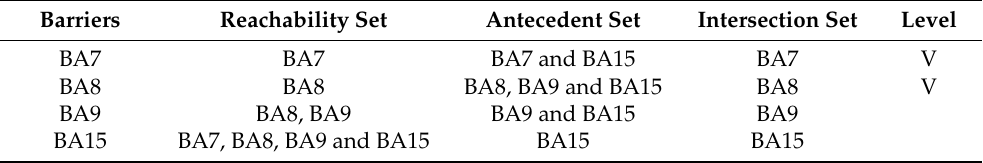
Table 14. Level VI partition of the hierarchical structure of the barriers using a final reachability matrix. Barriers Reachability Set Antecedent Set Intersection Set Level BA9 BA9 BA9 and BA15 BA15 Table 15. Level VII partition of the hierarchical structure of the barriers using a final reachability matrix. Barriers Reachability Set Antecedent Set Intersection Set Level BA15 BA15 BA15 BA15 VII